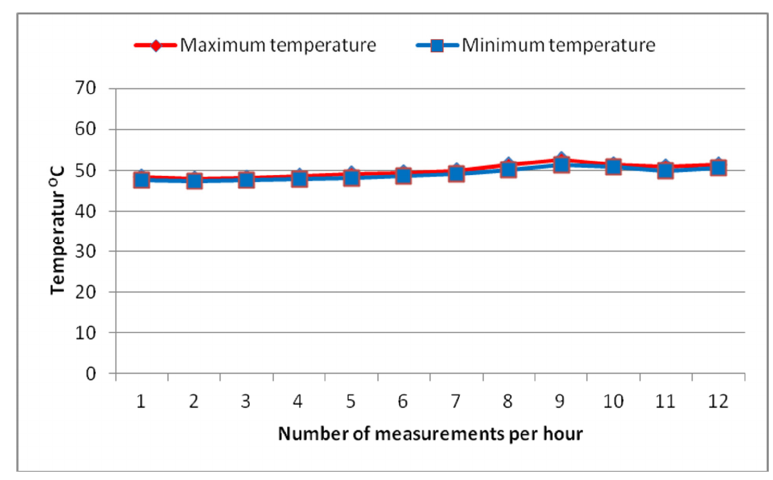
Figure 9. Temperature variation over 60 min for gear II of conveyor